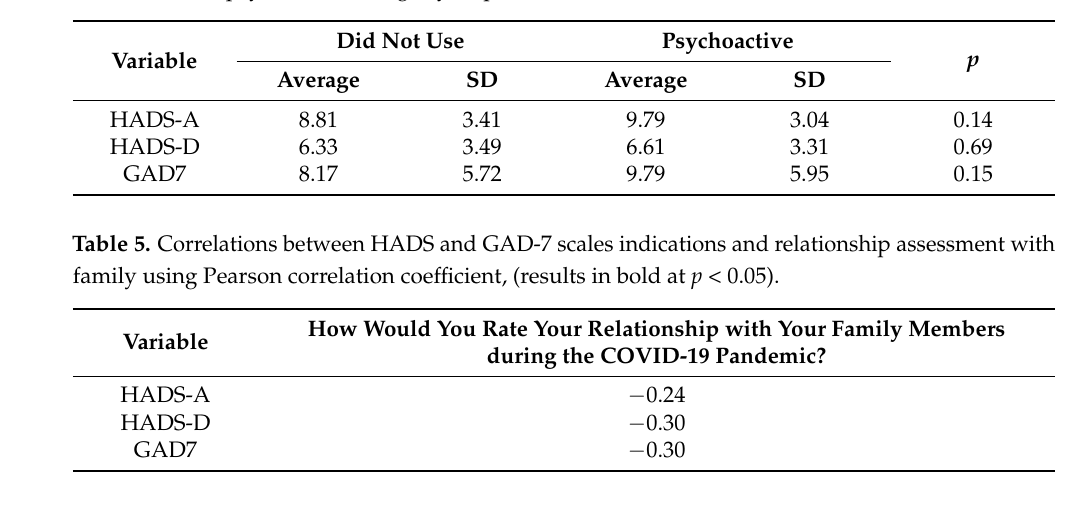
Table 4. Use of psychoactive drugs by respondents and results of the HADS and GAD-7 scales.